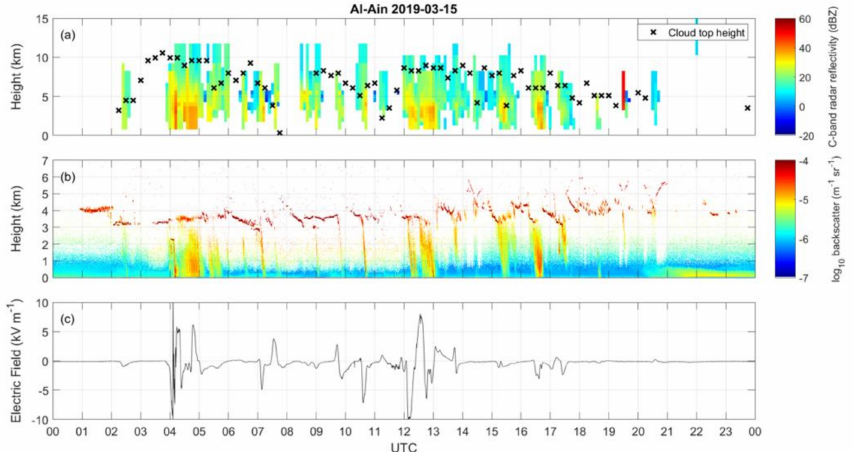
Figure 2. Time series of ( a ) C-band radar reflectivity (dBZ), ( b ) ceilometer lidar backscatter, and ( c ) vertical electric field strength for the measurement site at Al Ain airport, UAE, on 15 March 2019 (the crosses in ( a ) show the derived cloud top height using Meteosat8 data, as described in the